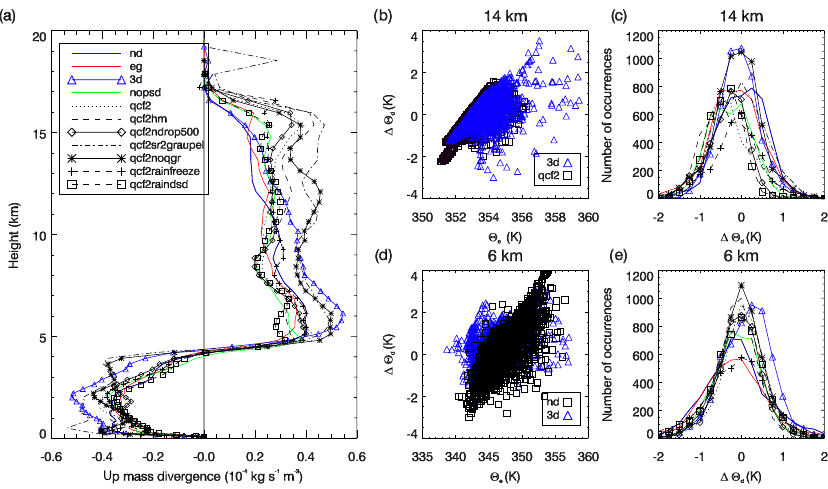
Figure 5. (a) Vertical profile of convective updraught ( > 1ms − 1 ) mean horizontal mass divergence (10 − 4 kgs − 1 m − 3 ) at 18:00UTC. (b) Scatter plot of θ e against (cid:49)θ d at 14km for two simulations that change the turbulent mixing (3d), and add an additional ice prognostic variable and have smaller ice sizes (qcf2). (c) Histogram of (cid:49)θ d at 14km. (d) As in (b) except for 6km and comparing the control (nd) and the 3d simulations and (e) as in (c) except for 6km. See text for